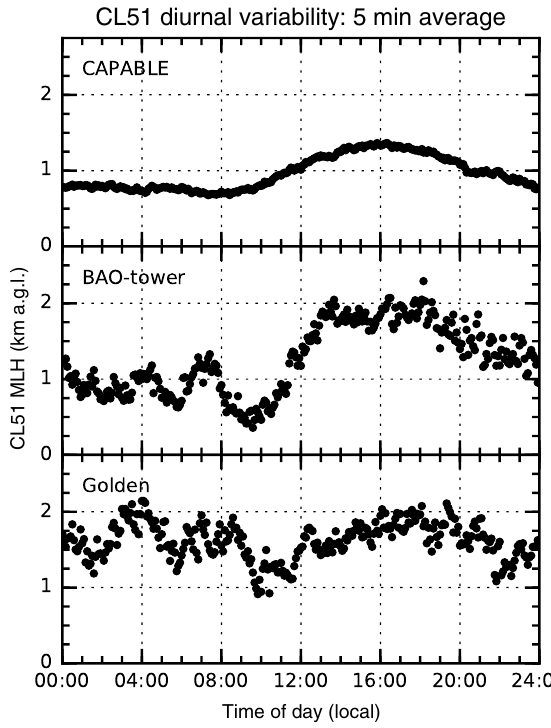
Figure 3. Diurnal variability of the MLH at the three sites. Data were resampled to 5min averages and